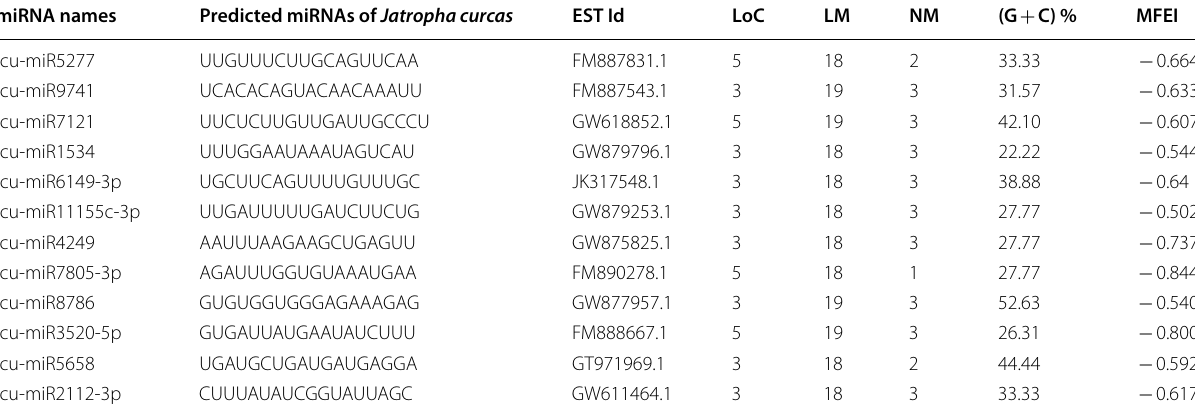
LoC Location of miRNAs, LM Length of miRNA, NM Number of mismatches, MFEI Minimal Folding Free Energy Index